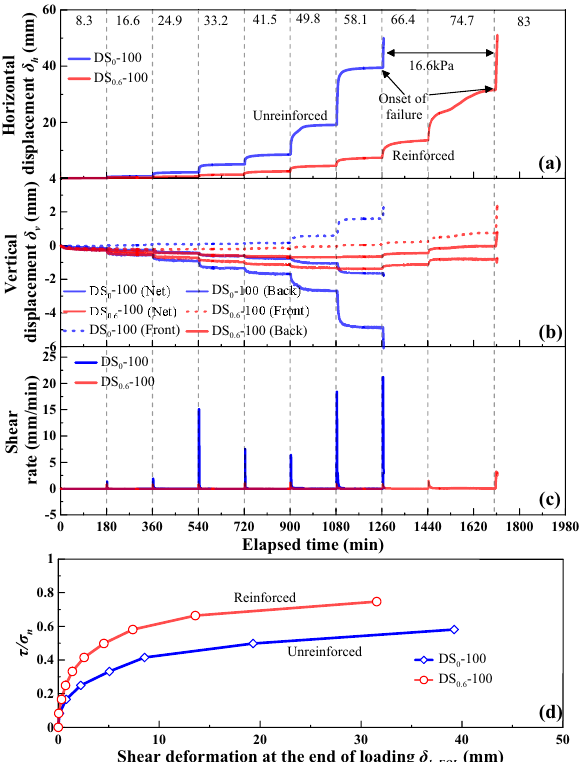
Figure 7. Shear behaviour for the reinforced specimen ( ω = 18% and %waste straw = 0.6) and the unreinforced specimen ( ω = 18%) under σ n = 100 kPa: ( a ) shear displacement ( δ h ) versus elapsed time relationship, ( b ) vertical displacement ( δ v ) versus elapsed time relationship ( c ) shear rate versus elapsed time relationship, and ( d ) ratio of shear stress to total normal stress ( τ / σ n ) versus shear displacement at the end of each increment of shear load ( δ h-EOL ) relationship.